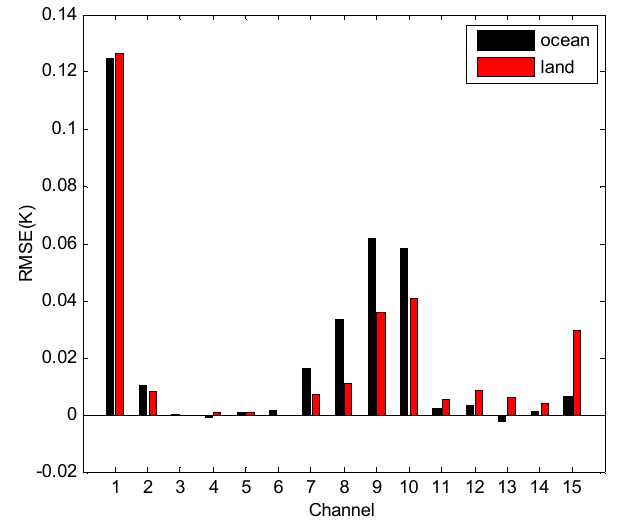
Figure 10. RMSE of bias correction using the first guess as the bias predictors minus the RMSE of bias correction using the ECMWF reanalysis as the bias predictors.